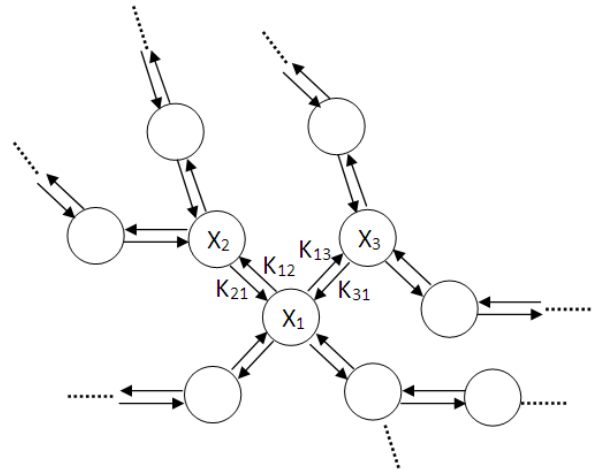
Figure 1. A sketch of the most general first order chemical kinetic